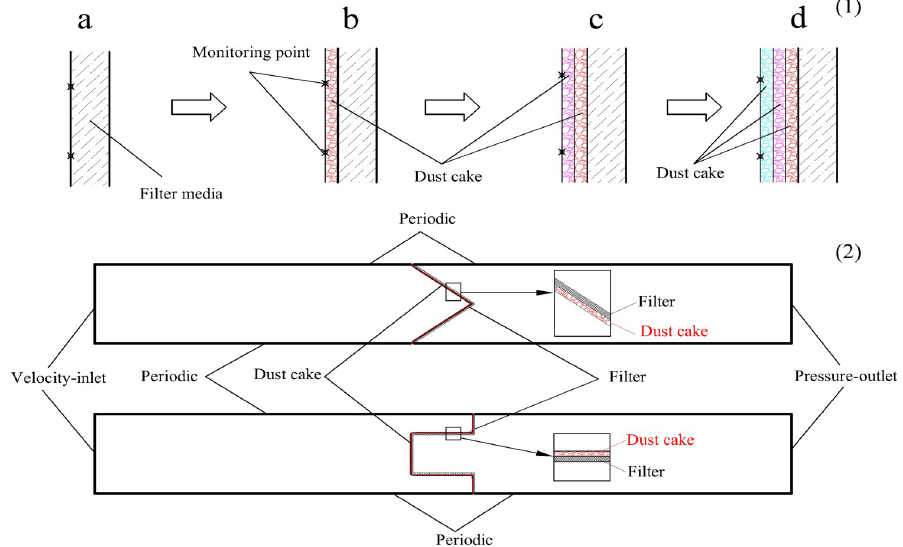
Fig 13. Numerical simulation computational zone during dust loading (1) formation of dust cake during dust loading (2) computational domain.